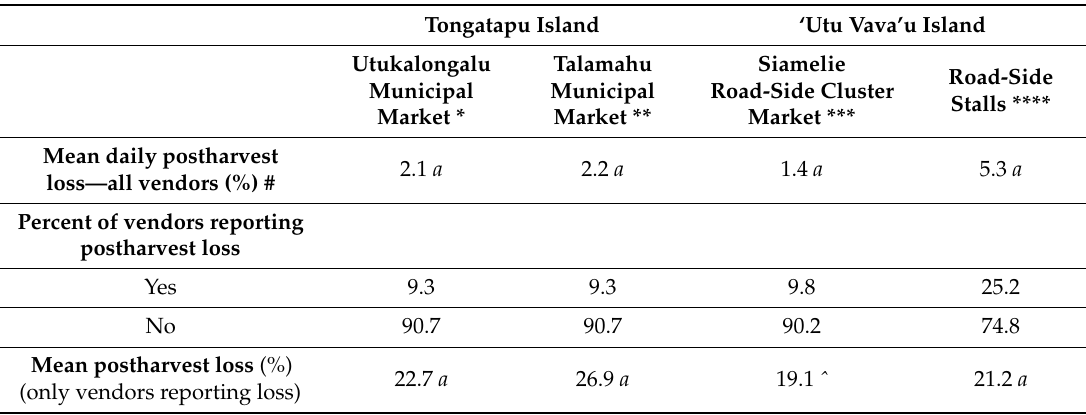
Table 3. Mean postharvest horticultural loss and the proportion of vendors reporting postharvest loss in the fruit and vegetable markets on ‘Utu Vava’u and Tongatapu Islands,